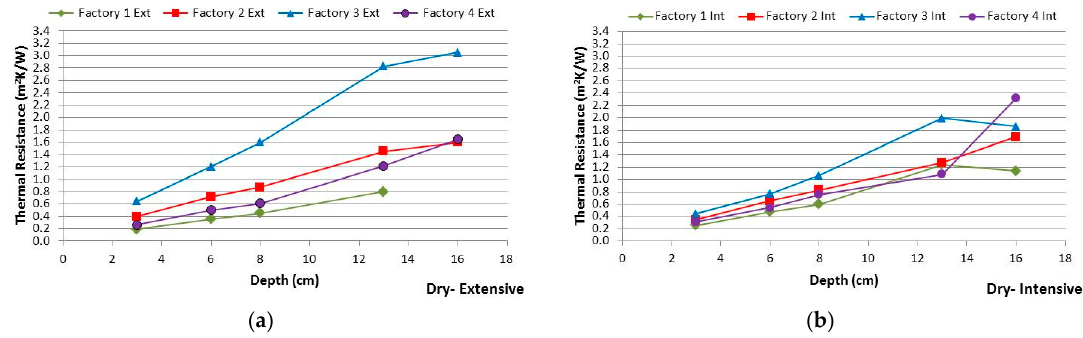
Figure 2. The green rectangle shows the growing media conductivity range, while the blue lines represent the natural soils conductivity values.